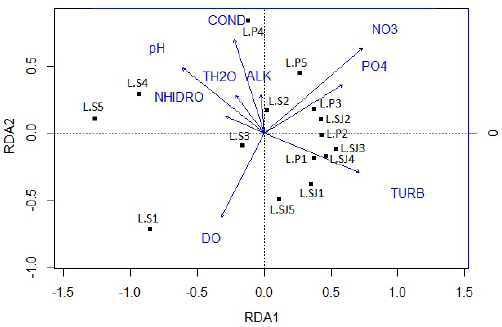
Figure 6. Ordination diagram of Redundancy Analysis (RDA), illustrating the relationships between environmental variables and lentic environments over time, based on species composition data.